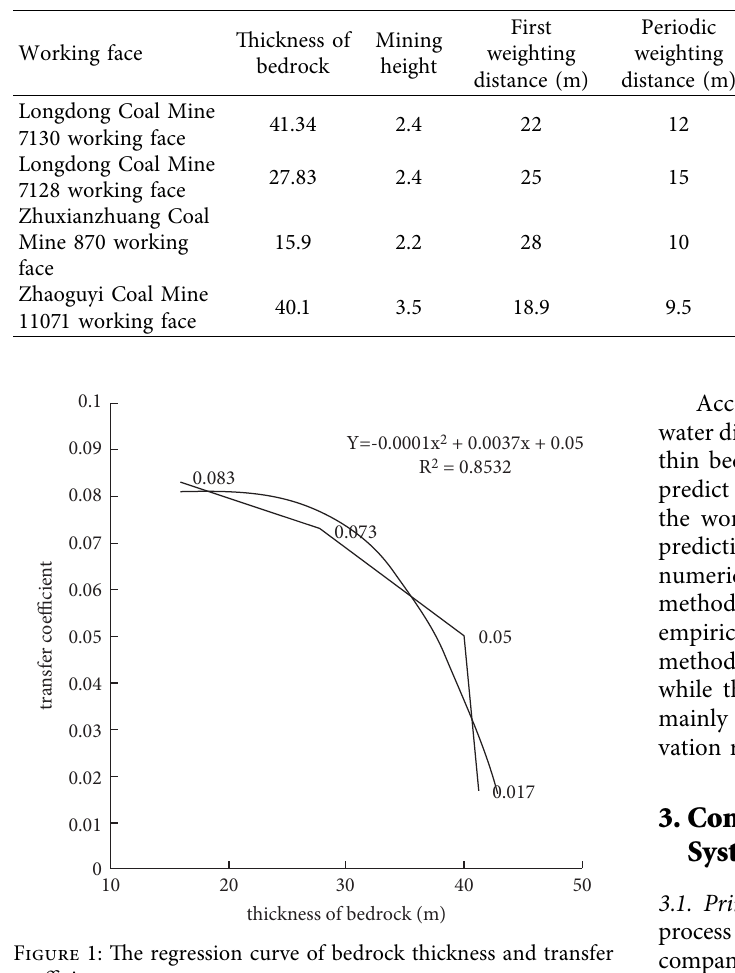
Table 1: Statistical table of data related to the transfer coefficient of the loose layer in the working face.